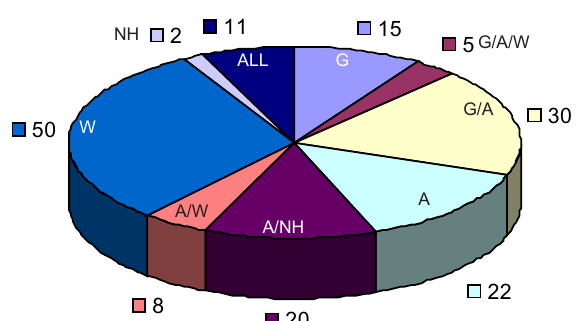
ALL Figure 2. Number of bird species observed in various